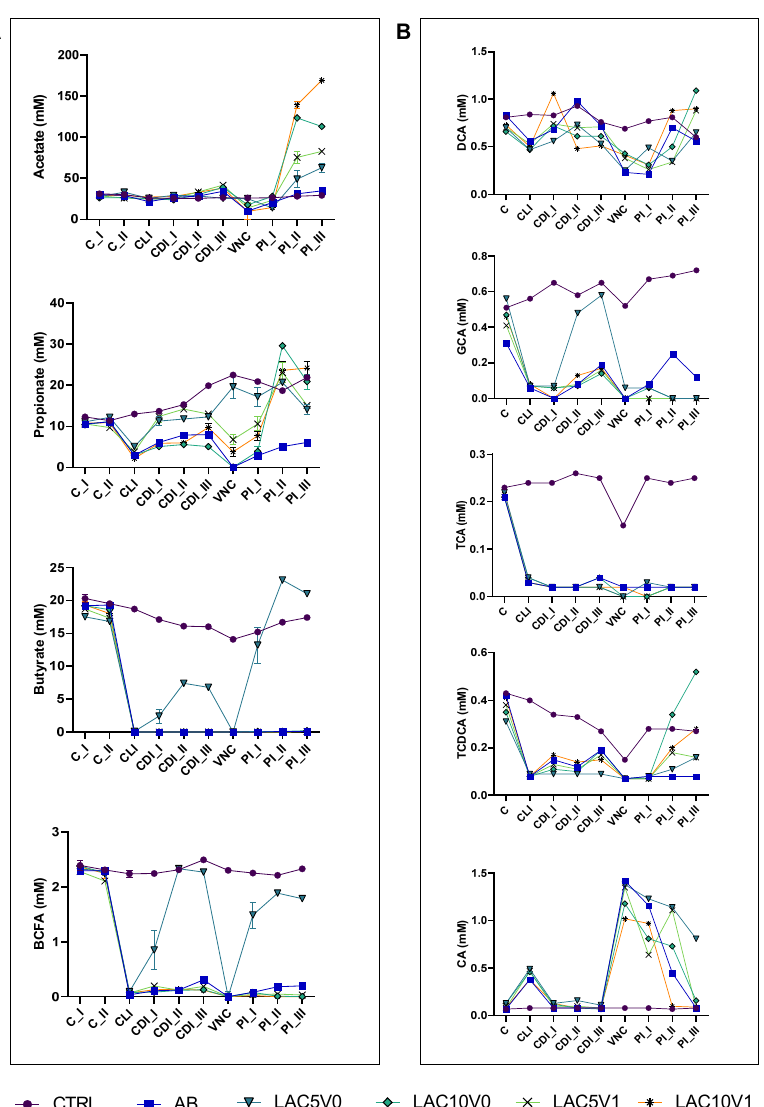
LAC5V1 vs. CTRL, p < 0.0001 for LAC10V0 and LAC10V1 vs. AB, p = 0.0004 for LAC5V0 vs. AB and p = 0.1290 for LAC5V1 vs. AB) (Supplementary Figure S8).